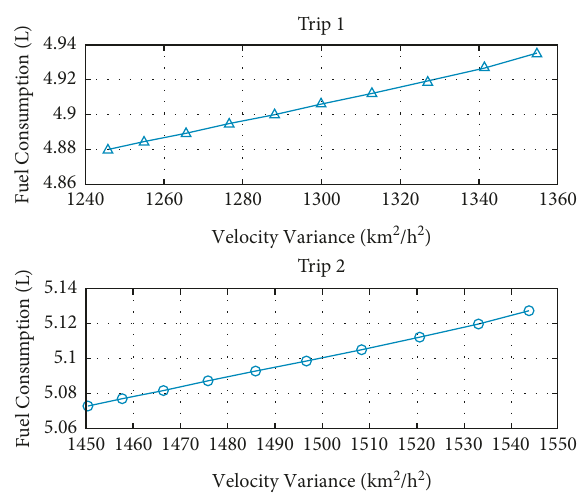
Figure 8: Fuel consumption with velocity variance in the cycles for Trip 1 and Trip 2.